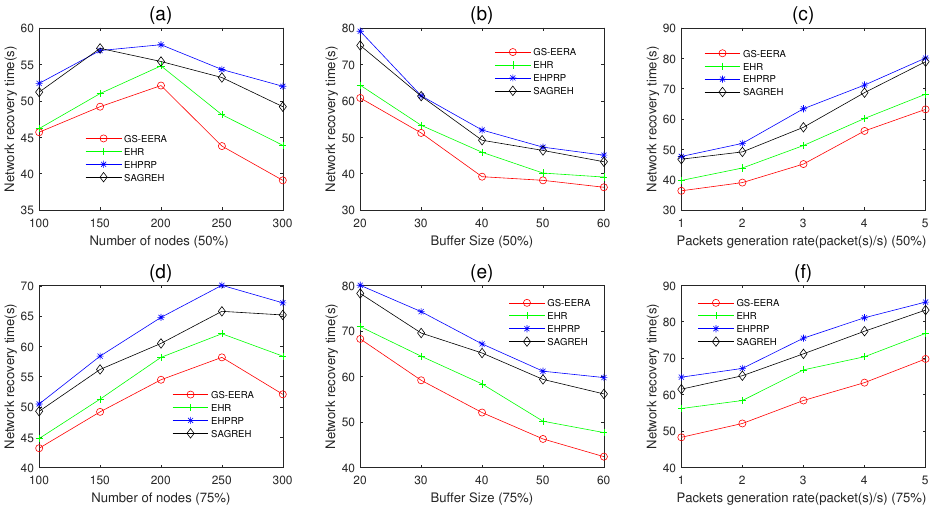
Figure 16. The network recovery